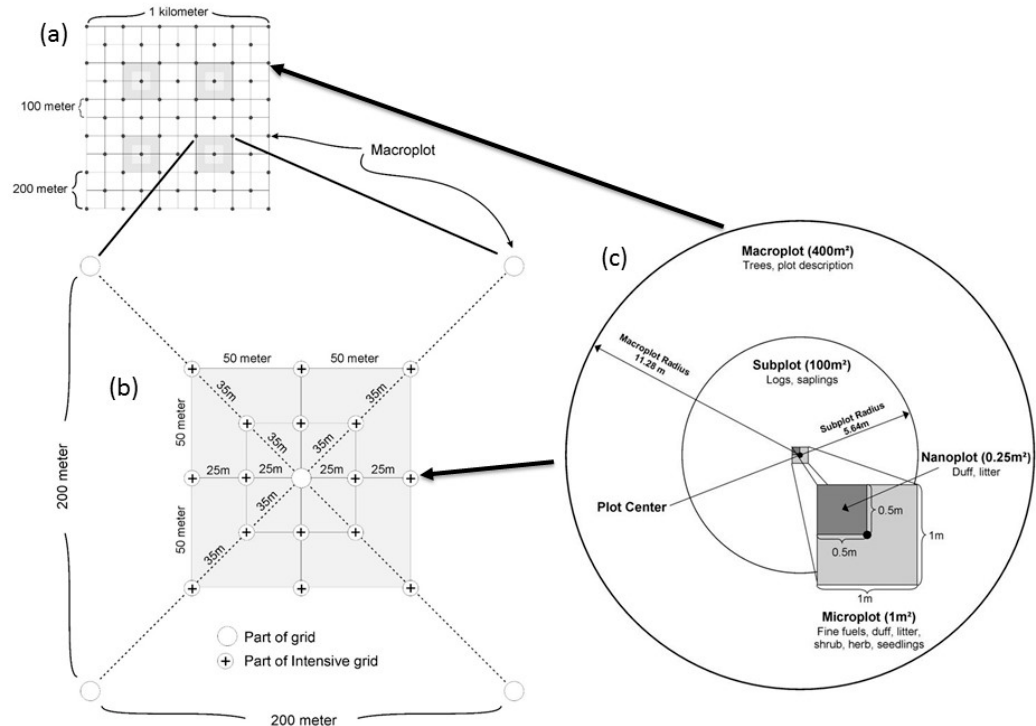
Figure 2. The sampling design of the FUELVAR study showing ( a ) the 1 km 2 sampling grid, ( b ) the intensification of the grid, and ( c ) the nested plot sampling scheme in the upper right.